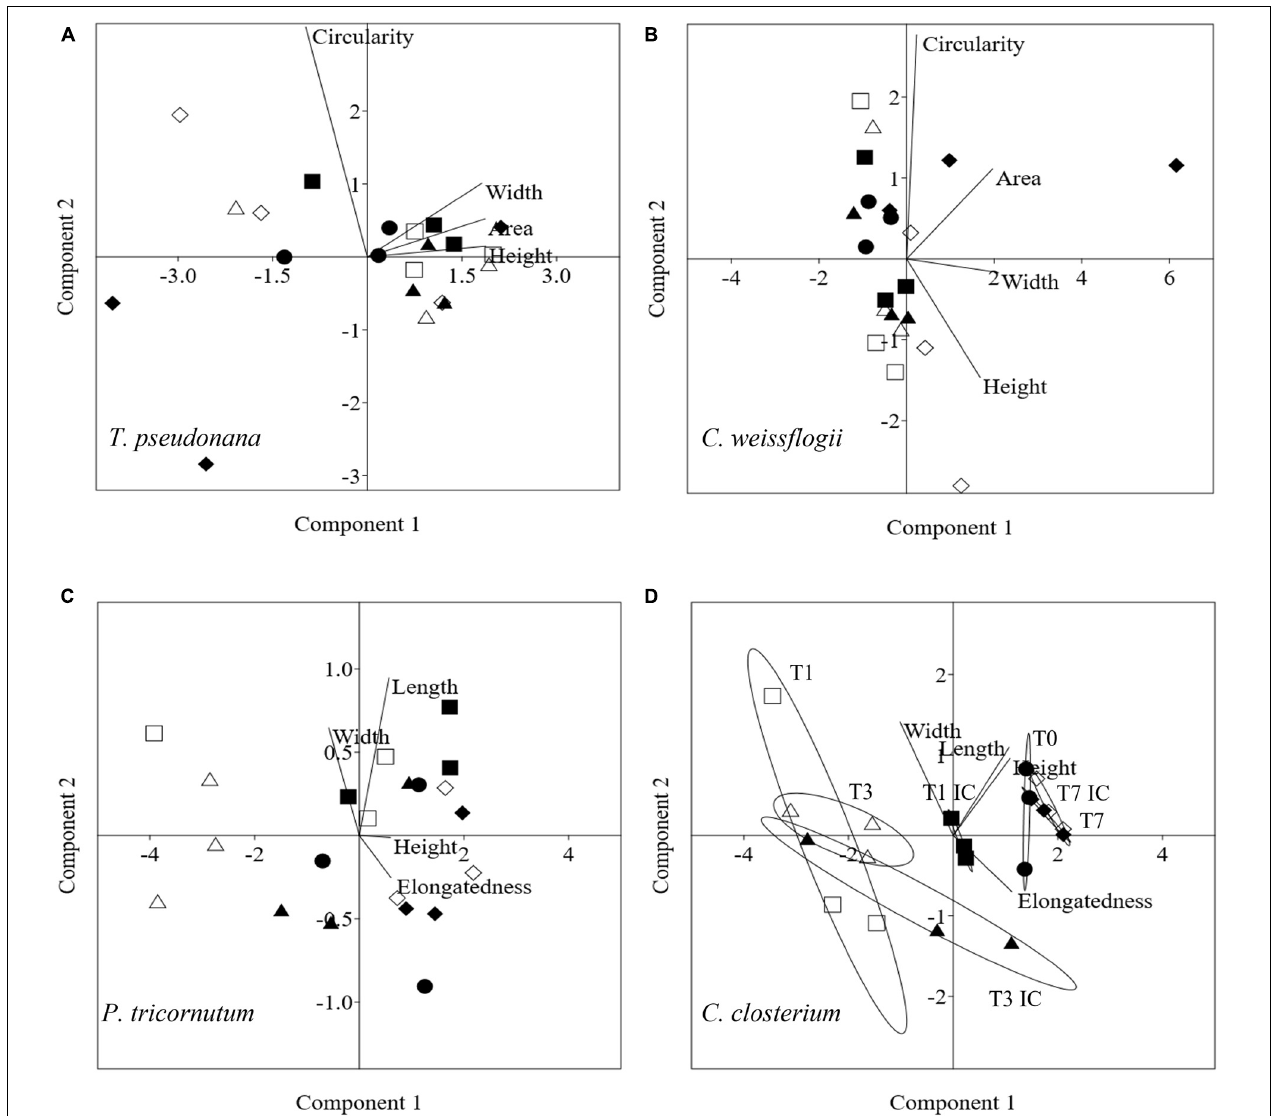
FIGURE 8 | PCA analysis on morphological characteristics in T. pseudonana (A) , C. weissflogii (B) P. tricornutum (C) and C. closterium (D) when mixed together. Different symbols indicate different time during the experiment: T0 ◦• ; T1 (cid:3)(cid:4) , T3 (cid:52) (cid:78) , T7 ♦(cid:7) ; white symbols indicate copepods exposure while black symbols indicate absence of copepods and interspecies competition (IC)